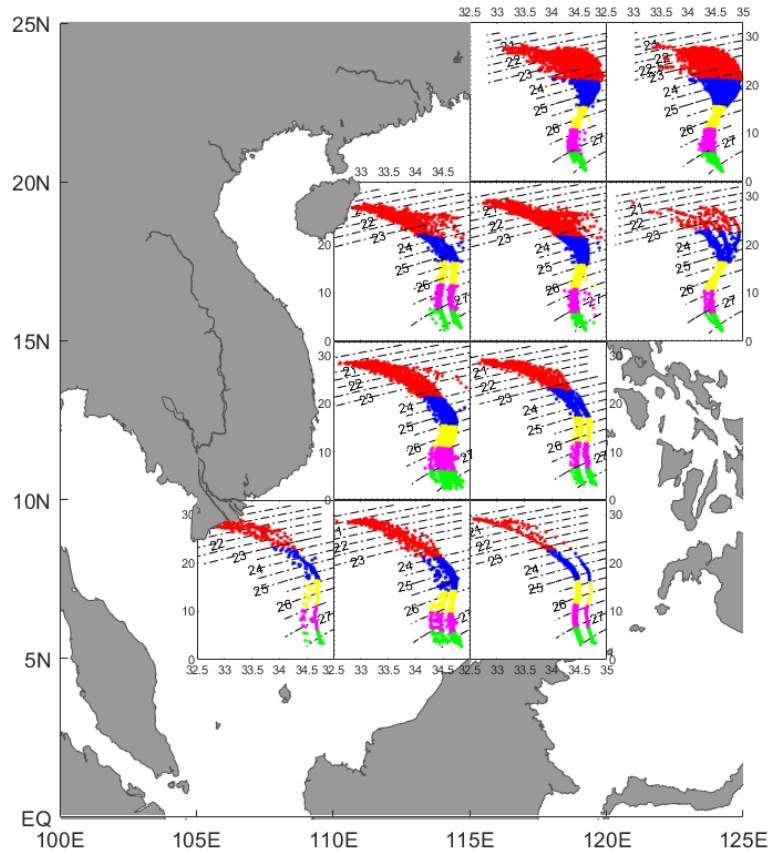
Figure 8. The same as Figure 5 but in autumn.